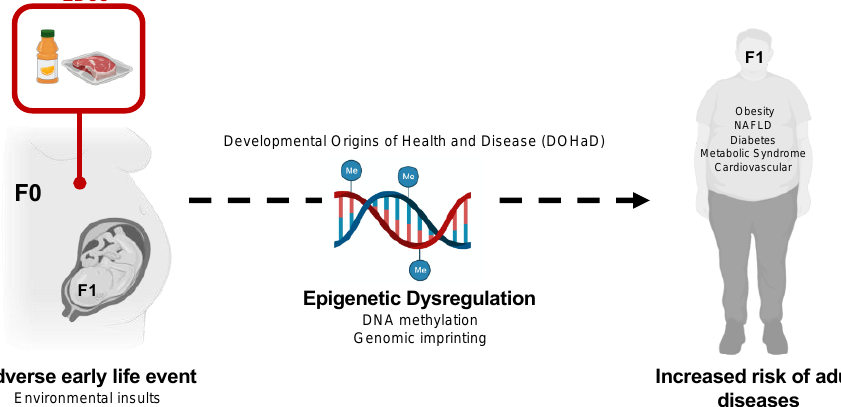
Figure 1. Endocrine disrupting chemicals, developmental programming, and human health. The predominant source of Environment and Development of Children (EDC) exposure is through our diet. EDCs can leach into the food by changes in temperature or pH when using plastic food containers. Human exposure to EDCs begins as early as in the mother’s womb (F0), where EDCs have been demonstrated to cross the placenta and reach the fetus. The Developmental Origins of Health and Diseases hypothesis suggests that environmental insults, including EDCs, during critical periods of early development and growth predisposes offspring (F1) to an increased risk of adult diseases. EDCs can have a profound impact on the fetal-maternal endocrine profile leading to altered fetal growth and metabolism, which increases the risk of metabolic diseases manifested during adulthood. These metabolic diseases include obesity, diabetes, metabolic syndrome, non-alcoholic fatty liver disease (NAFLD), and cardiovascular dysfunction. Although the biological mechanisms behind these associations remain unclear, an involvement of epigenetic dysregulation has been proposed to have a role in gene-environment interactions and disease risk. EDC-induced changes in metabolic gene profiles may arise from altered global or gene-specific DNA methylation patterns and consequently cause detrimental effects on genomic imprinting. (Me = Methyl